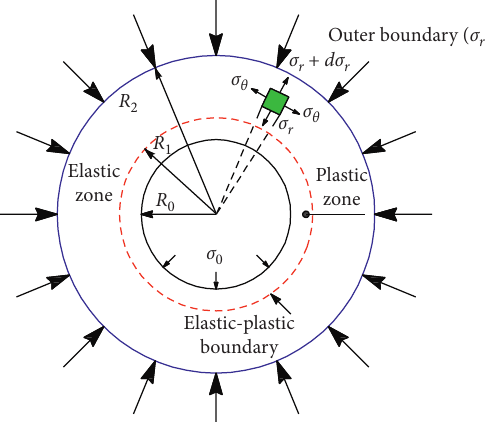
Figure 5: Calculation model of the circular opening with finite or infinite